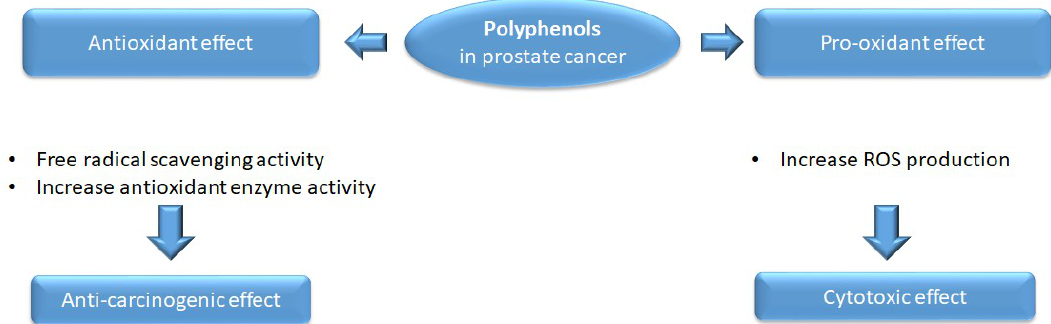
Figure 1. Antioxidant and pro-oxidant effects of polyphenols in prostate cancer. Polyphenols can act as both antioxidant molecules, by free radical scavenging, and as pro-oxidant agents, by increasing ROS production—the mechanisms are dependent on the concentrations applied. In addition, polyphenols are able to increase the level of antioxidant enzymes in prostate cancer cell lines or in animal models of prostate cancer.